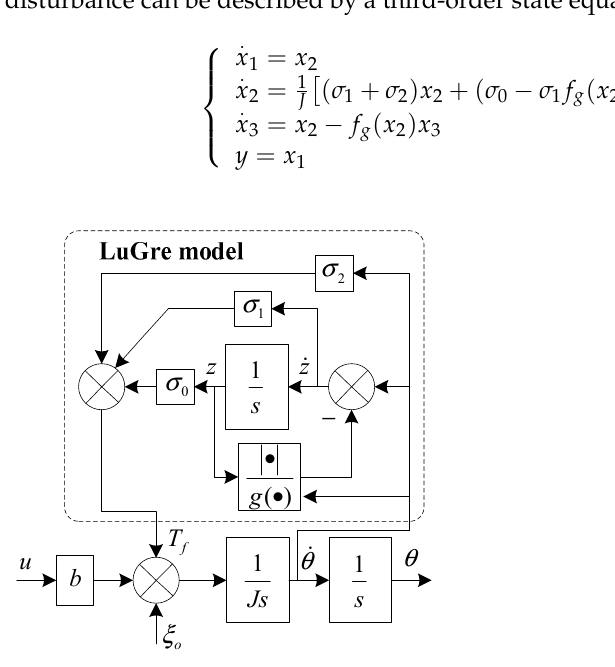
Figure 3. Mathematical model of PMSMs with friction disturbance.